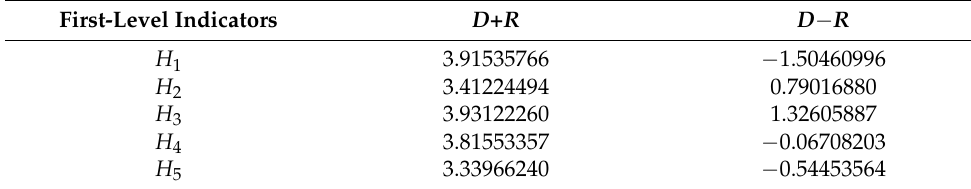
Table 1. Table 1. Centrality and causality of first-level indicators.